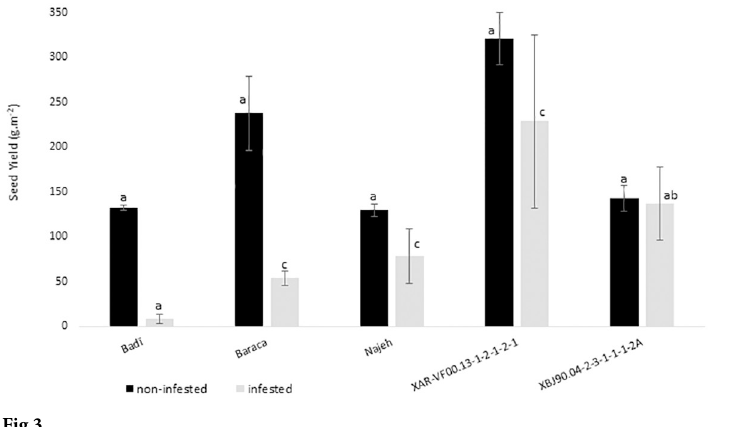
cantly affected ( P � 0.01) the host plant chlorophyll content index (CCI) and F all the studied genotypes (Figs 4 and 5). All genotypes showed significant difference between infected and non-infected plants before Orobanche emergence. Between 125 and 146 DAP, CCI decreases under O . foetida infestation varied from 23.6% for Baraca to 77.2% recorded for Badi. Respective decreases of 19.4% and 30.8% were recorded for the same genotypes under free Orobanche field. Clear differences were observed for the CCI between infected and free Orobanche plants. Such differences were more pronounced for the susceptible check Badi. Variation between 125 and 146 DAP, varied from 4.2% for Baraca to 46.4% observed for Badi. F /F ratio was significantly affected by Orobanche parasitism (Fig 5). In infected plants F v m F decreased by 58.8% (0.789 to 0.325) for the susceptible check Badi against only 9.9% (0.787 m to 0.709) observed for free Orobanche plants. Decreases of 46.2%, 14.5%, 5.9% and 4.7% were